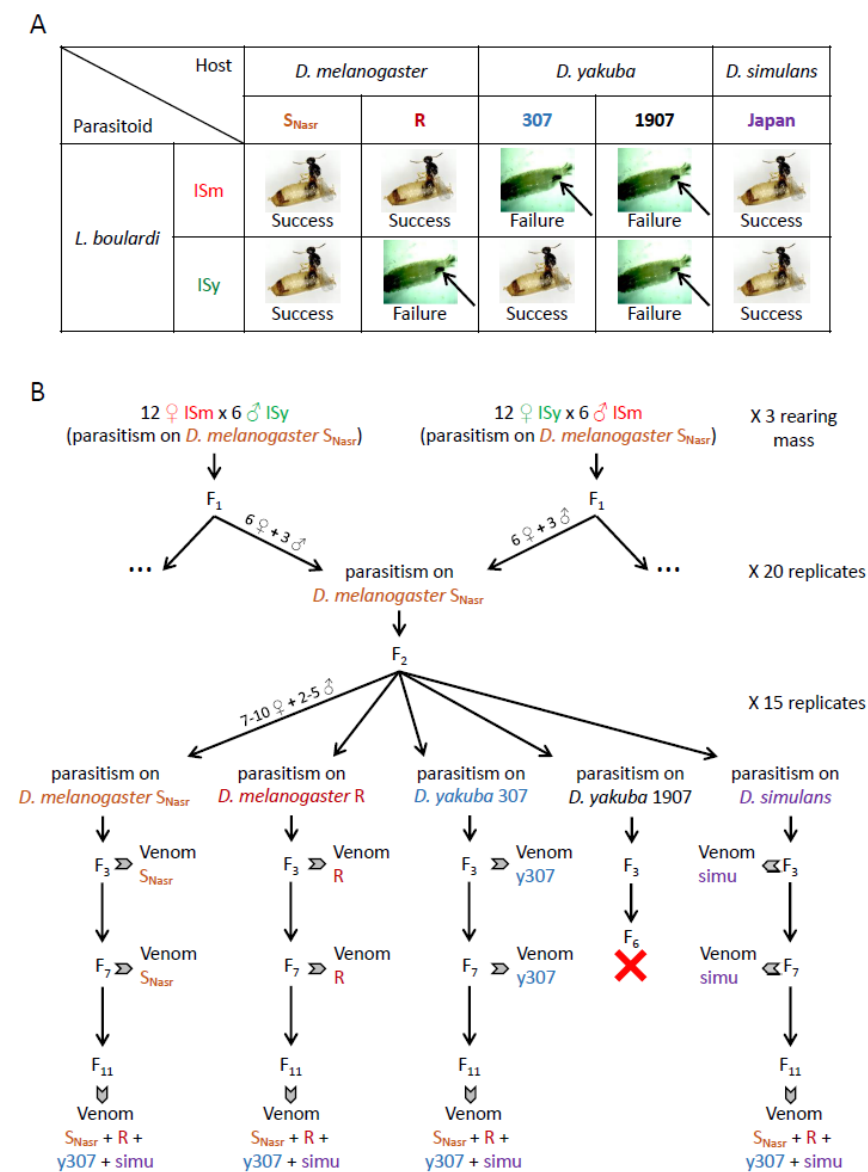
Figure 1. Biological model and experimental evolution protocol. A. Outcome of interaction between the five host strains ( D. melanogaster S Nasr , D. melanogaster R, D. yakuba 307, D. yakuba 1907 and D. simulans ) and the two L. boulardi lines (ISm and ISy). The black arrow shows an encapsulated parasitoid egg inside a Drosophila larva. B. Design of the experimental evolution. ISm and ISy: ISm and ISy lines of L. boulardi ; S Nasr : D. melanogaster S Nasr ; R: D. melanogaster R; y307: D. yakuba 307; simu: D. simulans . The red cross indicates the extinction of parasitoids reared on D. yakuba 1907, therefore no analysis was performed on individuals from this host. F 3 , F 7 and F 11 : the three generations of L. boulardi that were analyzed for venom composition and parasitic success. The F 3 is the first generation under